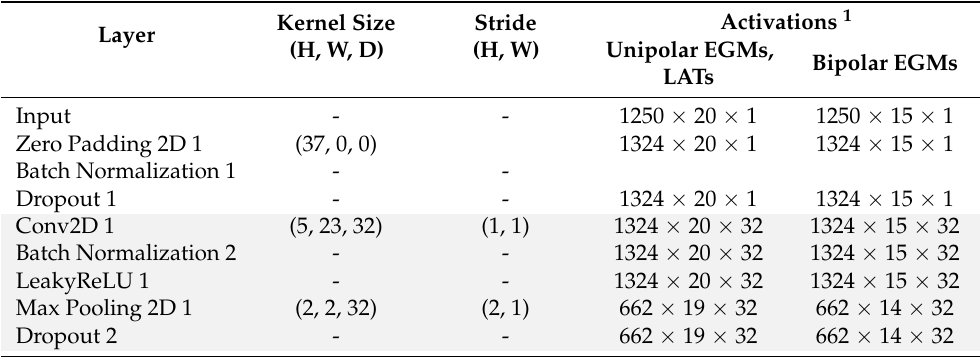
Table 3. CRNN model for rotational activity